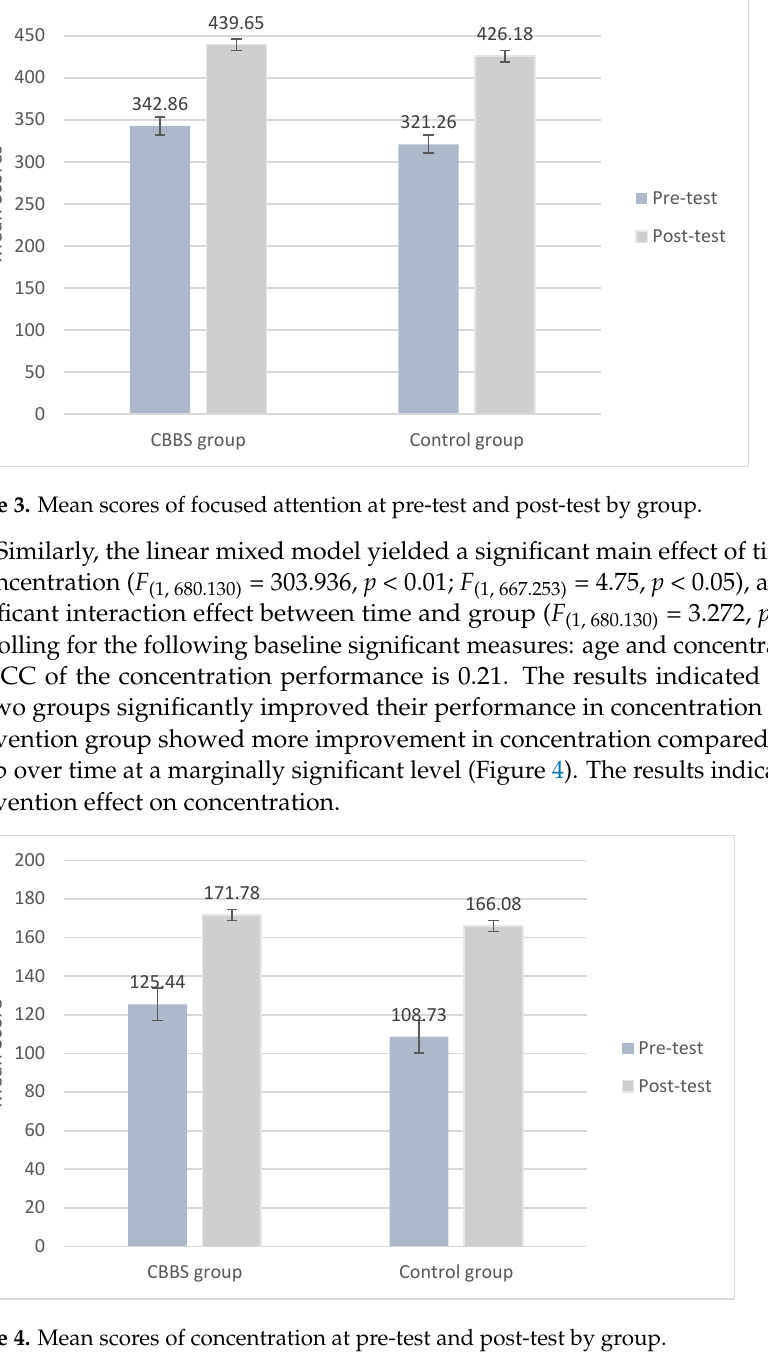
Figure 4. Mean scores of concentration at pre-test and post-test by group